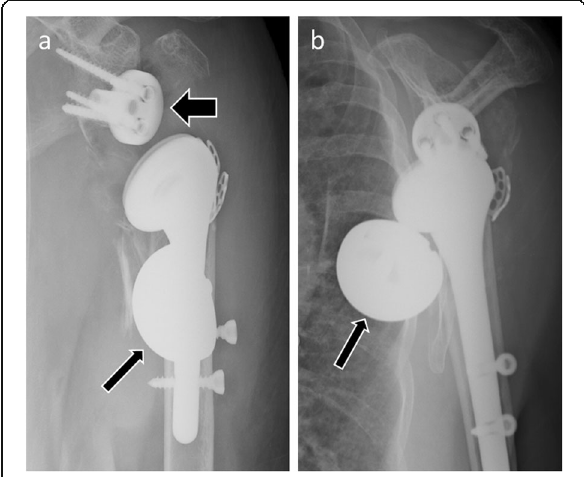
Fig. 11 Anteroposterior ( a ) and scapular Y ( b ) radiographs of a 87- year-old woman, with reverse shoulder arthroplasty placed 4 days earlier, show glenosphere anteroinferior dislocation (thin arrows).